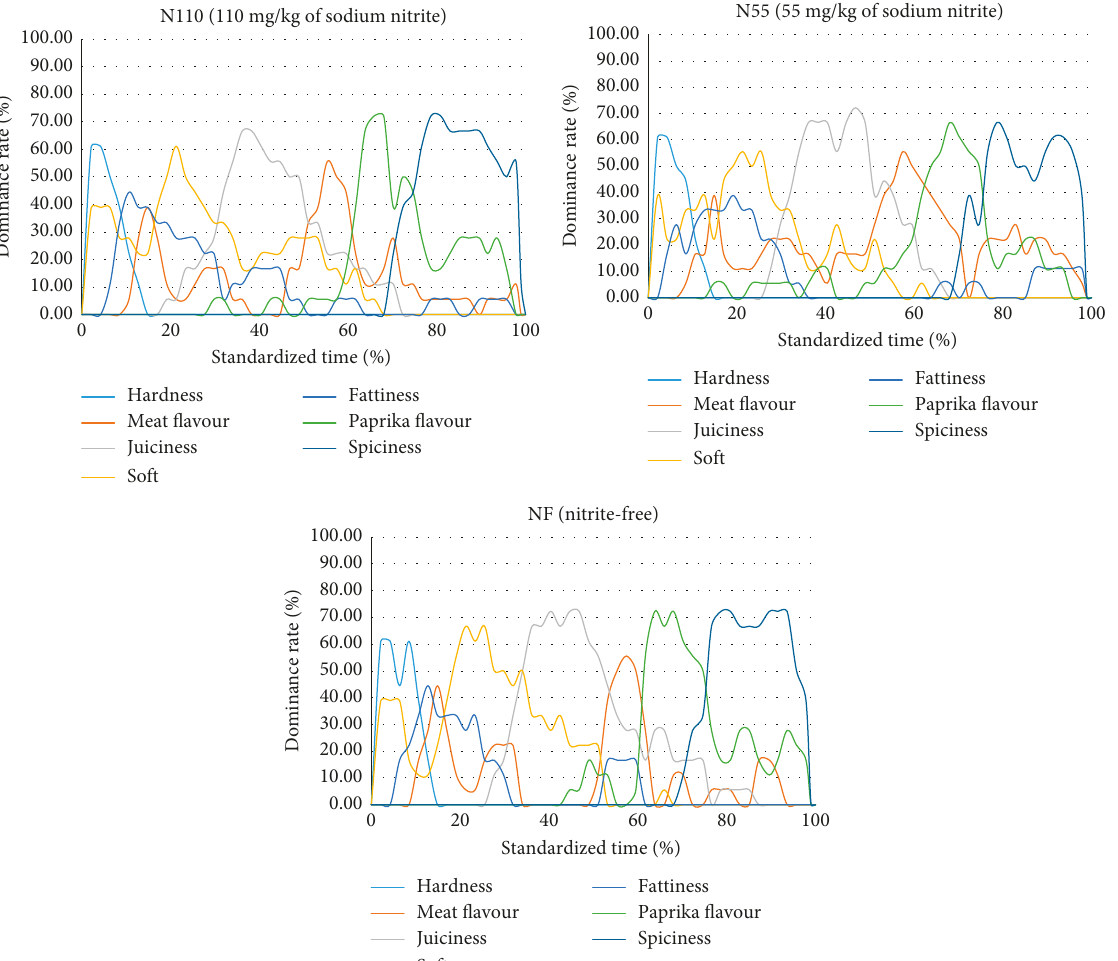
Figure 4: Temporal dominance sensations (TDS) curve of kulen formulated with different nitrite levels. t � 0 (0% of standardised time; moment of the first bite); t � 1 (100% of standardised time; moment of